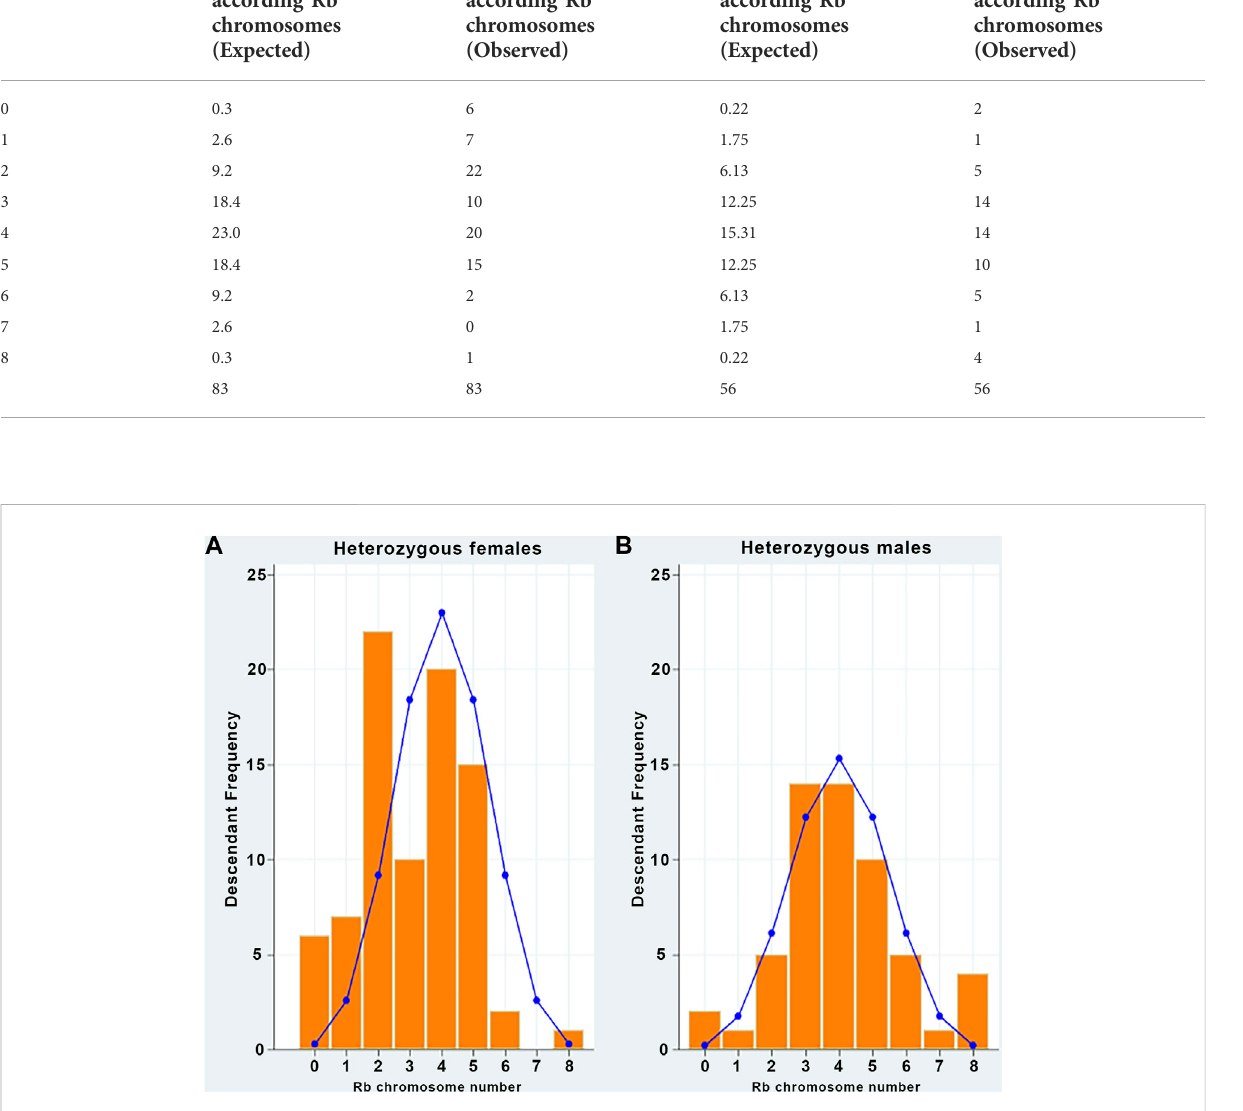
FIGURE 2 Observedfrequenciesdonot fi tthetheoreticalbinomialdistributions. (A) Observed(bars)descendantsfromheterozygousfemalesbyinherited Rbchromosomeand expected (curve) frequencies according to thebinomialdistribution ( p -value = 0.0000). (B) Observed (bars) descendants from heterozygous male by inherited Rb chromosome and expected (curve) frequencies according to the binomial distribution ( p -value =